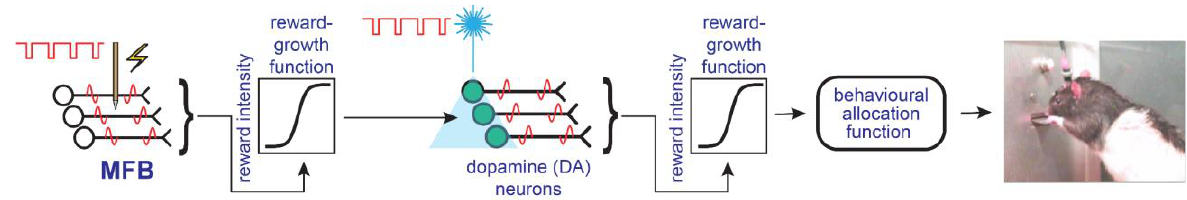
Figure 2. The series-circuit model (from [16]).